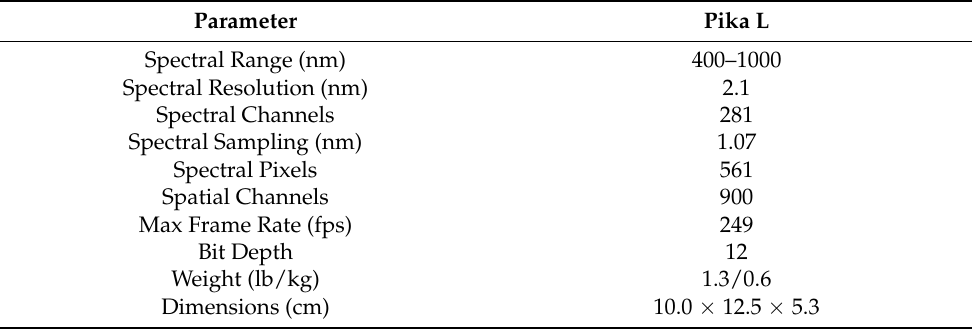
Table 1. Main technical parameters of the Pika L imaging